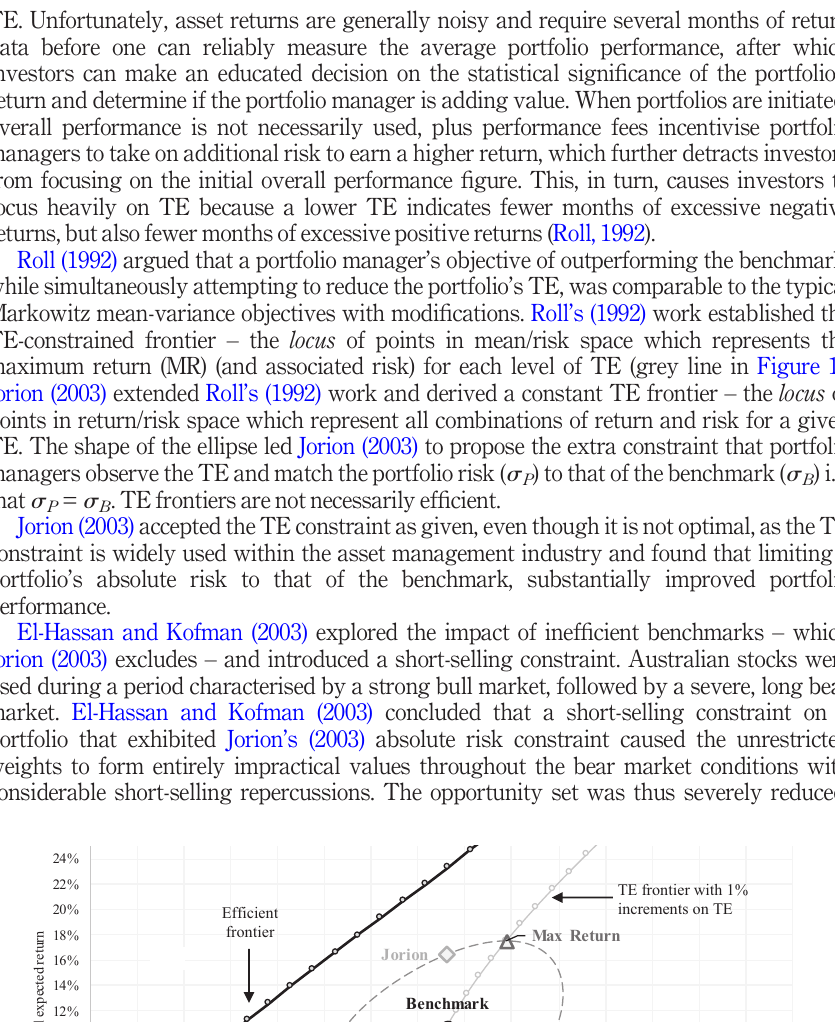
TE constrained frontier at